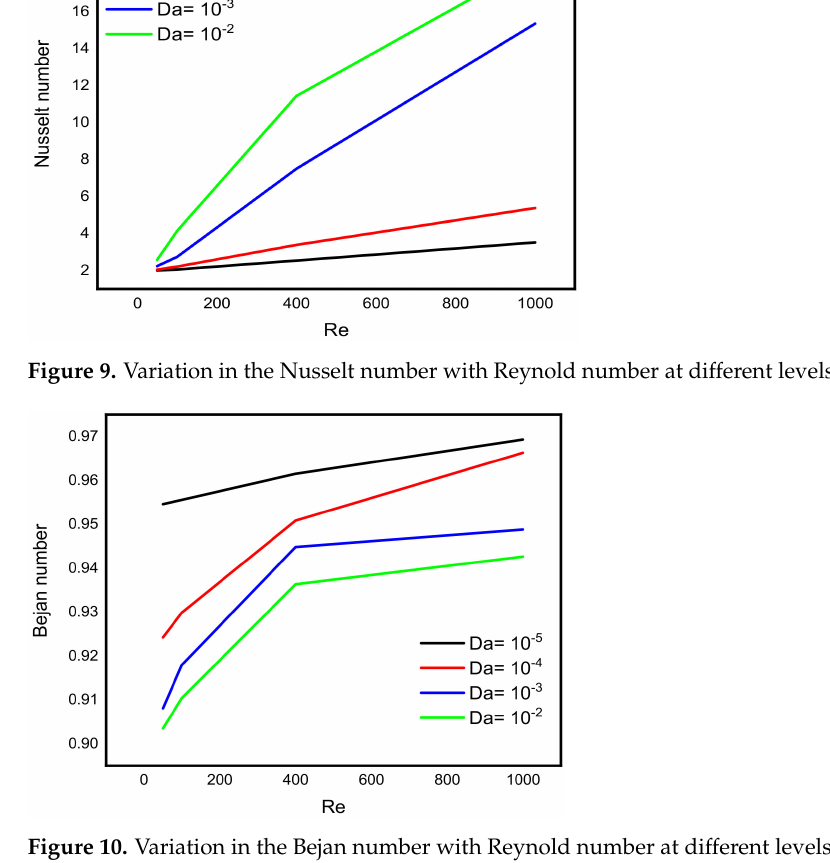
Figure 10. Variation in the Bejan number with Reynold number at different levels of Darcy number.